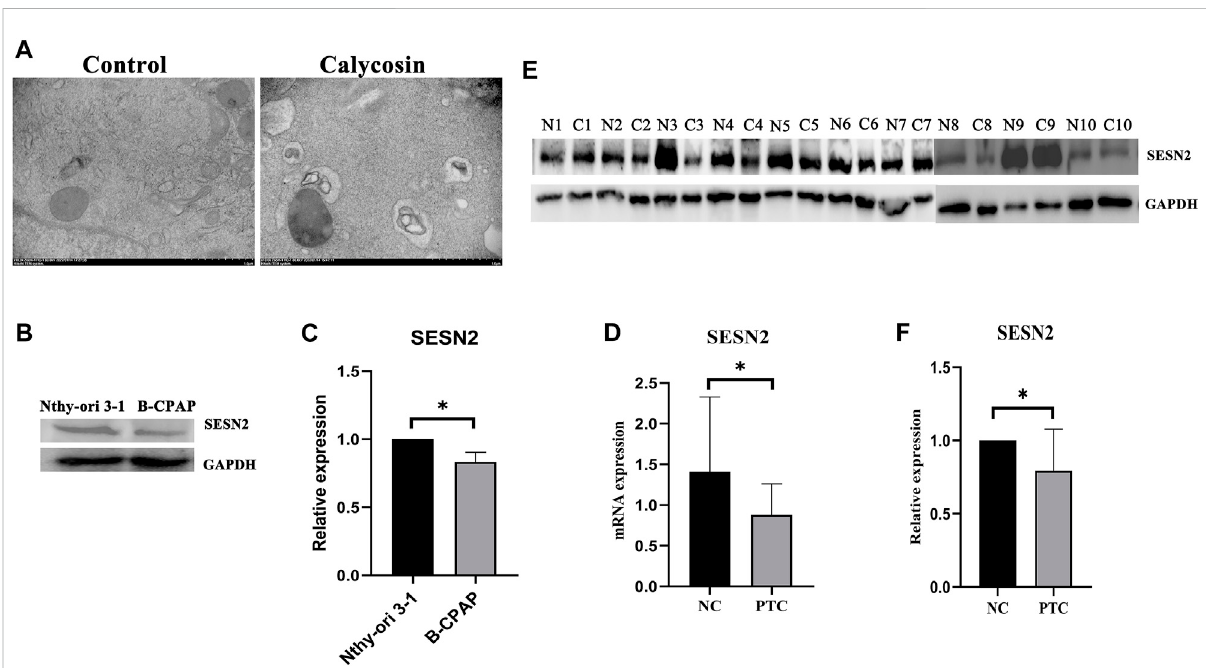
FIGURE 5 Calycosin induced B-CPAP cell autophagy (A) B-CPAP cells were treated with calycosin (100 µM) or control group for 24 h, washed with PBS, fi xedwith 2% glutaraldehyde, and imaged by transmission electronmicroscope to observe changes in cells. (B,C) SESN2 protein expression inNthy- ori 3-1 and B-CPAP cells. (D) SESN2 mRNA expression in PTC tissue and human normal thyroid tissue. (E,F) SESN2 protein in human PTC tissue (C) and normal thyroid tissue (N). * p <